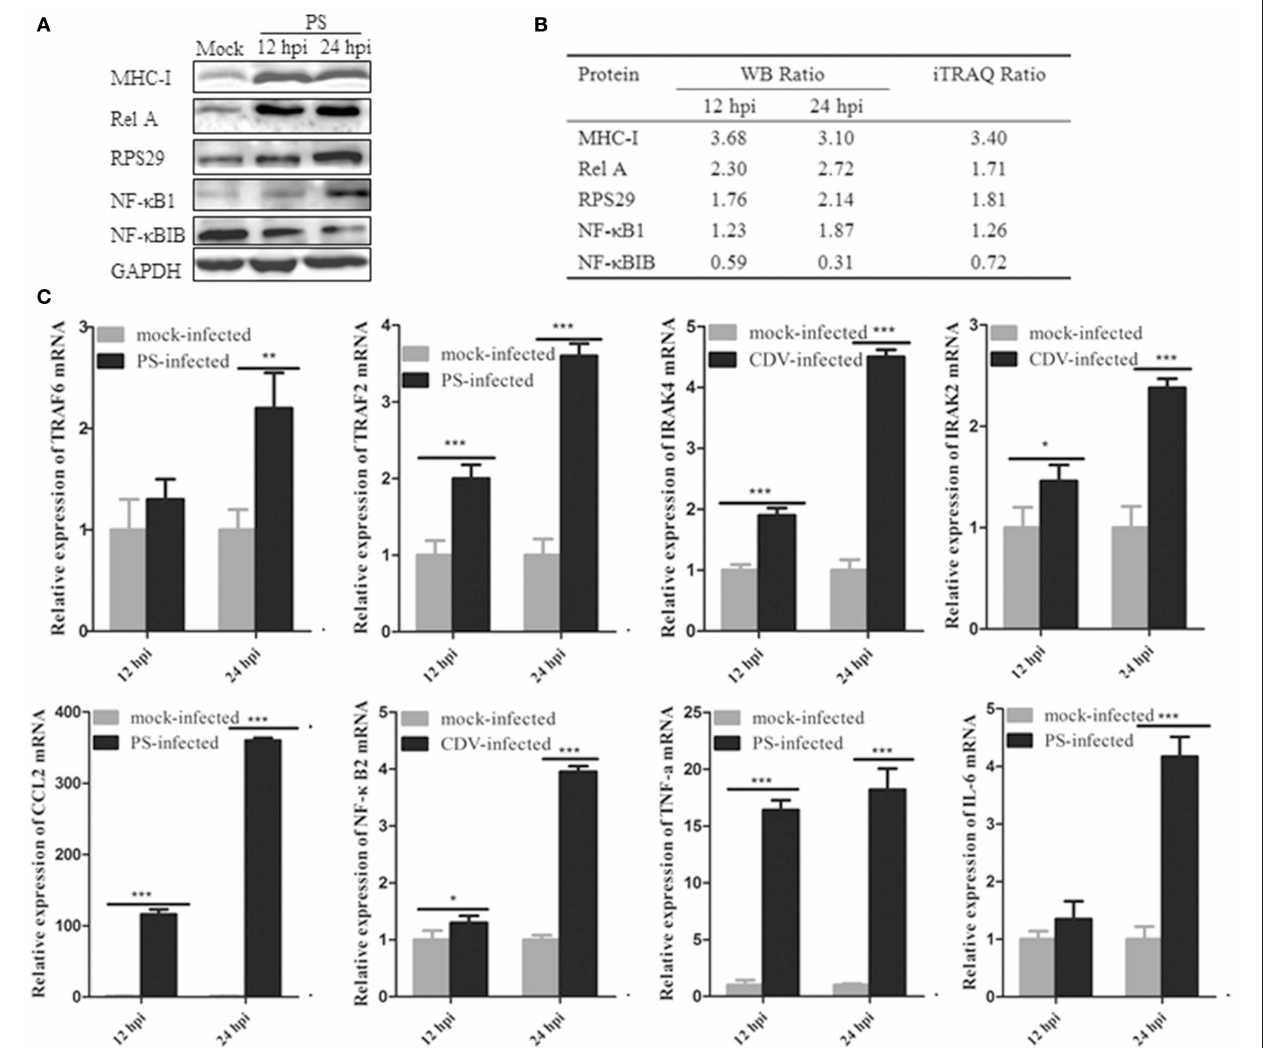
FIGURE 5 | Confirmation of the iTRAQ-MS data by western blotting or real-time RT-PCR. (A) Western blot analysis of NF- κ B1, RelA, MHC-I, RPS29, and NF κ BIB in PS-infected and control samples at 12 and 24 hpi. GAPDH was served as internal reference. (B) The intensity ratio of the corresponding bands (infection/mock) was quantified using ImageJ software and normalized against GAPDH. (C) Eight selected differently expression proteins related to NF- κ B pathway were testified using real-time RT-PCR method. Each gene was performed in three independent experiments. The relative gene expression was calculated using 2- 11 CT model, representative of n -fold changes in comparison with mock-infected samples. Error bars represent the standard error for triplicate samples. * P < 0.05; ** P < 0.01; *** P < 0.001. The data was analyzed by two-way ANOVA followed by Duncan’s